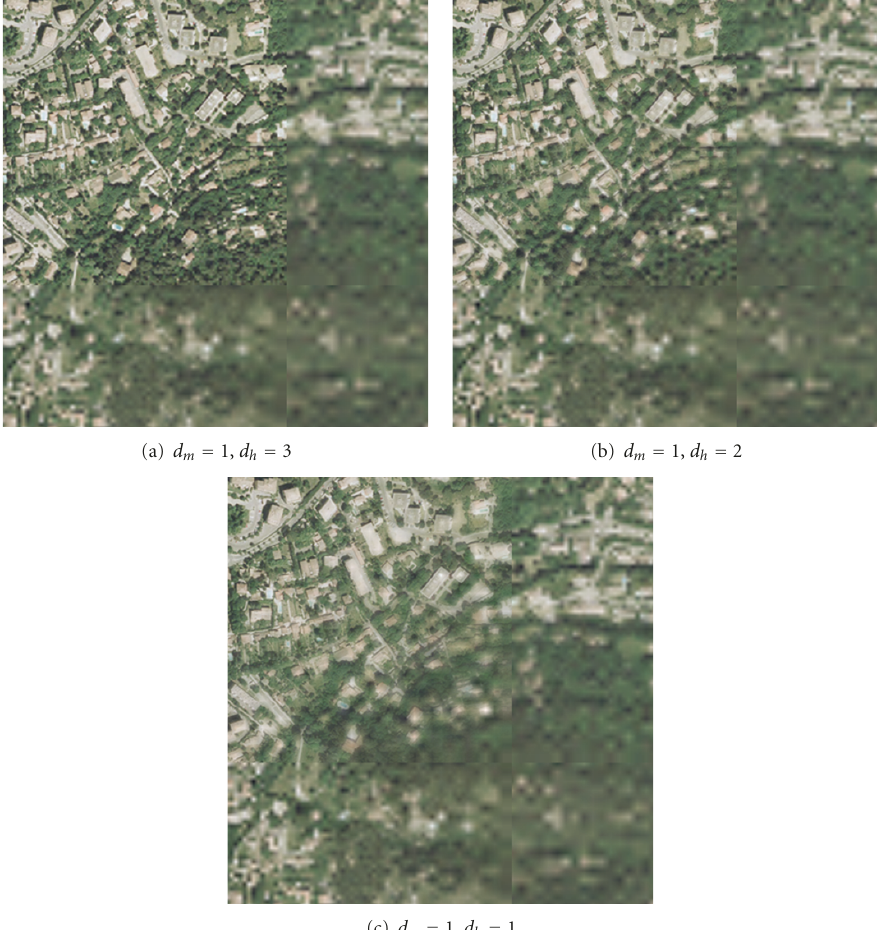
Figure 10: Example texture tessellation after the application of method I: l h = 0, l m = 2, l l =